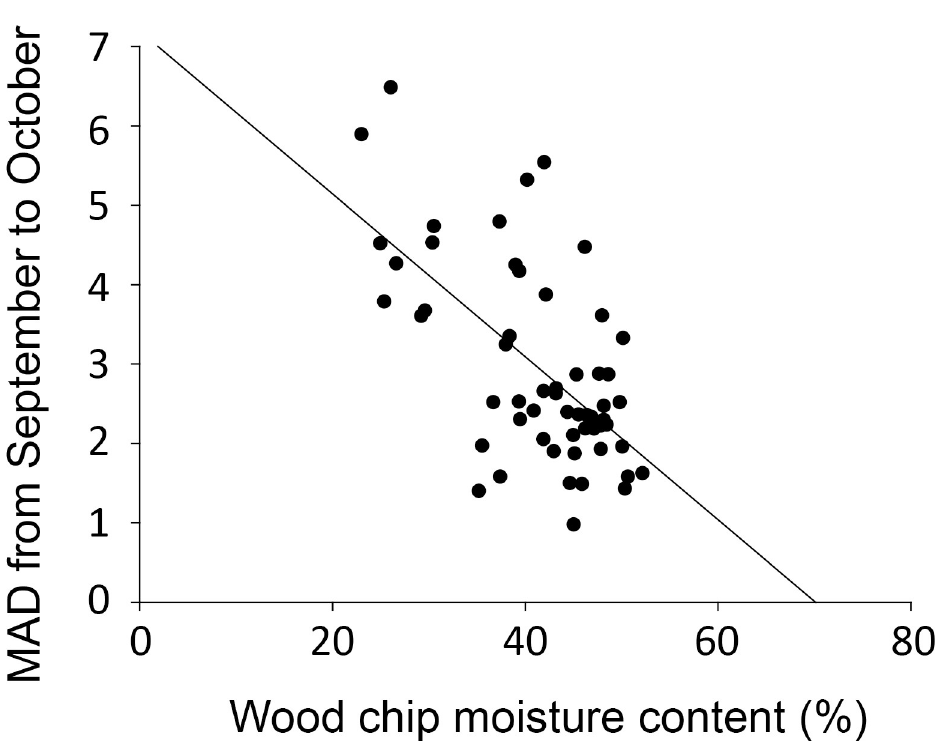
Fig 7. Correlation between wood chip moisture content and MAD from September and October. Wood chips were collected in September 2019. The bars and error bars stand for means and 95% confidence intervals, respectively.